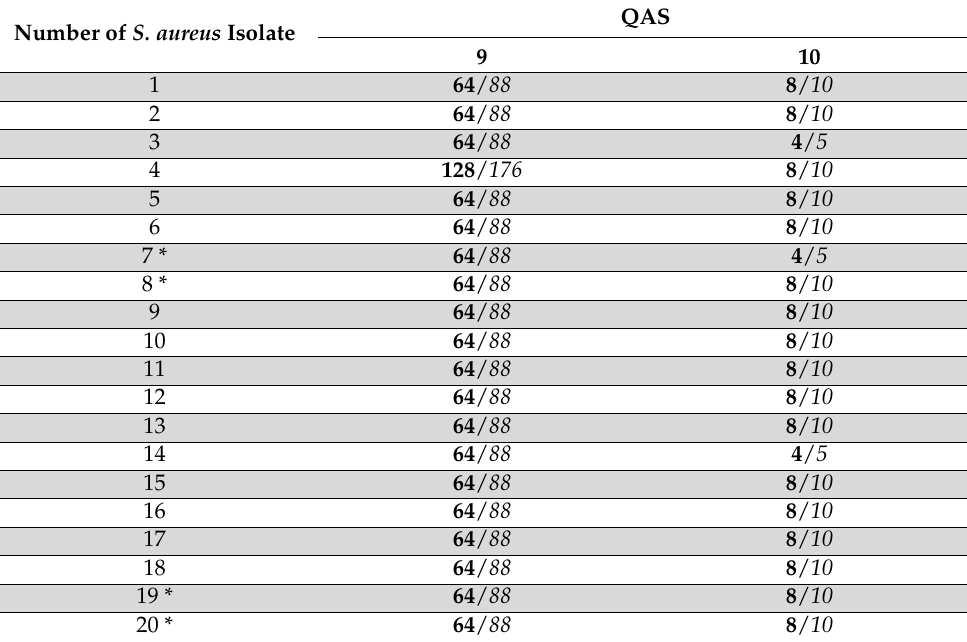
Table 2. MIC ([ µ g/mL ]/[ µ M] ) values for QAS 9 and 10 against S. aureus clinical isolates. Number of S. aureus